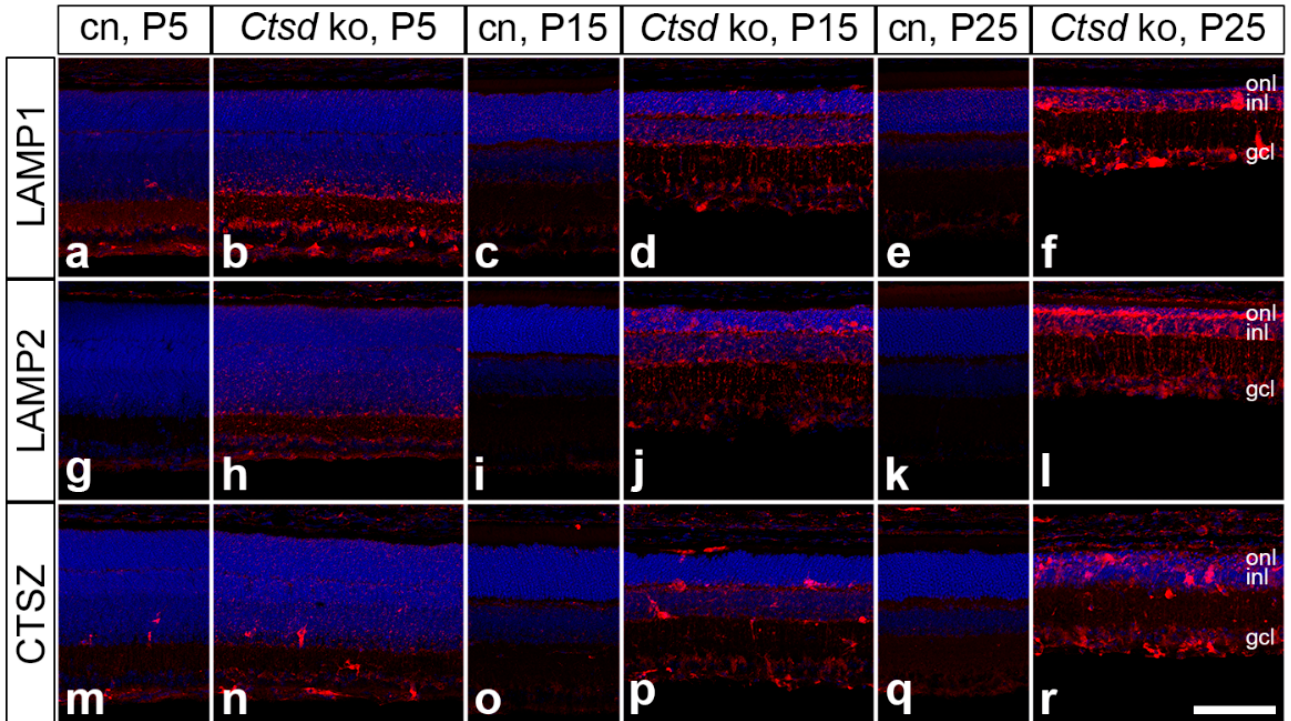
Figure 4. Dysregulation of lysosomal proteins in the Ctsd ko retina. LAMP1 ( b ), LAMP2 ( h ) and CTSZ ( n ) were moderately upregulated mainly in the ganglion cell layer and inner plexiform layer of P5 Ctsd ko mice when compared with age- matched control retinas ( a , g , m , respectively). Expression levels of LAMP1, LAMP2 and CTSZ were further increased in P15 Ctsd ko retinas ( d , j , p , respectively), and were prominent in all retinal layers of P25 mutant mice ( f , l , r , respectively) when compared with the corresponding control retinas ( c,e,i,k,o,q ). Note the presence of strongly CTSZ-immunoreactive cells in mutant retinas at all ages analysed. cn, control; CTSZ, cathepsin X/Z/P; gcl, ganglion cell layer; inl, inner nuclear layer; ko, knock-out; LAMP1, lysosomal-associated membrane protein 1; LAMP2, lysosomal-associated membrane protein 2; onl, outer nuclear layer; P, postnatal day. Scale bar: 100 µm.